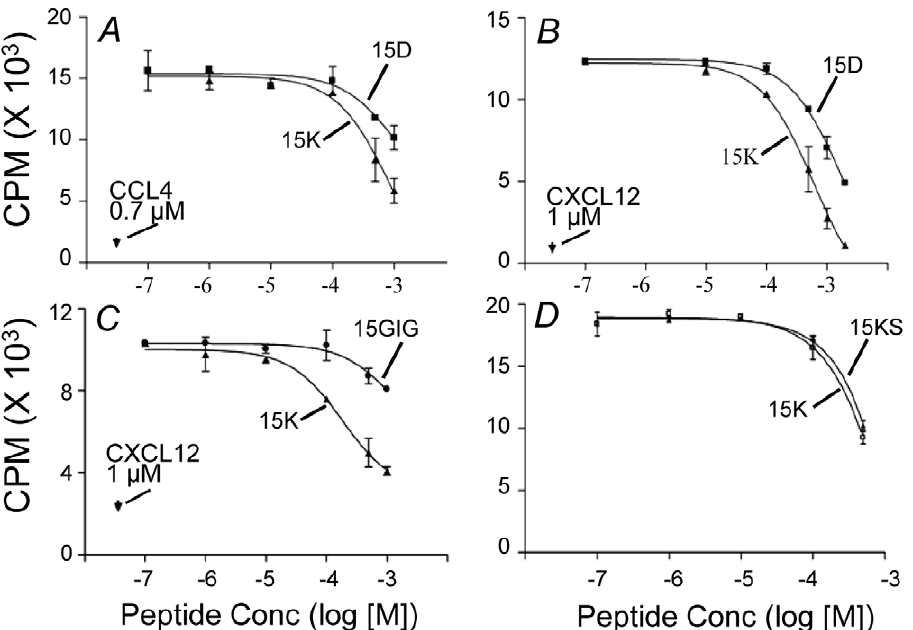
Figure 5. Inhibition of chemokine receptor ligand binding by peptide pre-treatment. (A) Effect of pre-treatment with peptides 15K and 15D on the binding of CCL4 to SupT1/CCR5 cells; (B) Effect of pre-treatment with peptides 15K and 15D on the binding of CXCL12 to CEMx174 cells; and (C) Effect of pre-treatment with 15K and control peptide 15GIG on the binding of CXCL12 to CEMx174 cells; (D) Effect of pre-treatment with peptides 15K and 15KS on the binding of CXCL12 to CEMx174. Binding studies were performed as described in Materials and Methods.